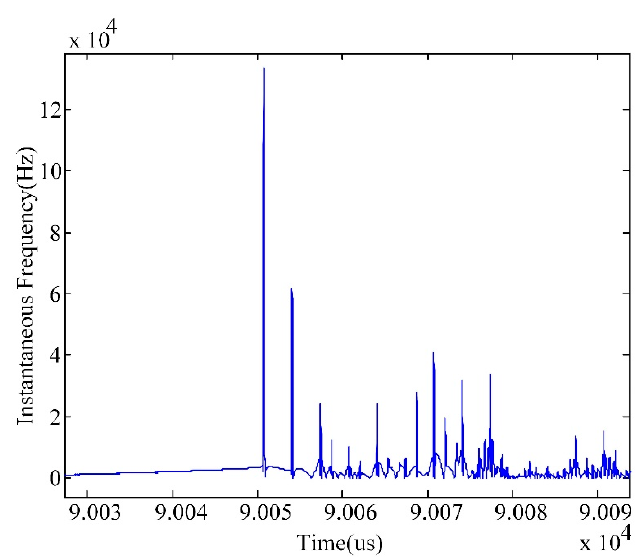
Figure 6. Relationship between the instantaneous frequency and time.